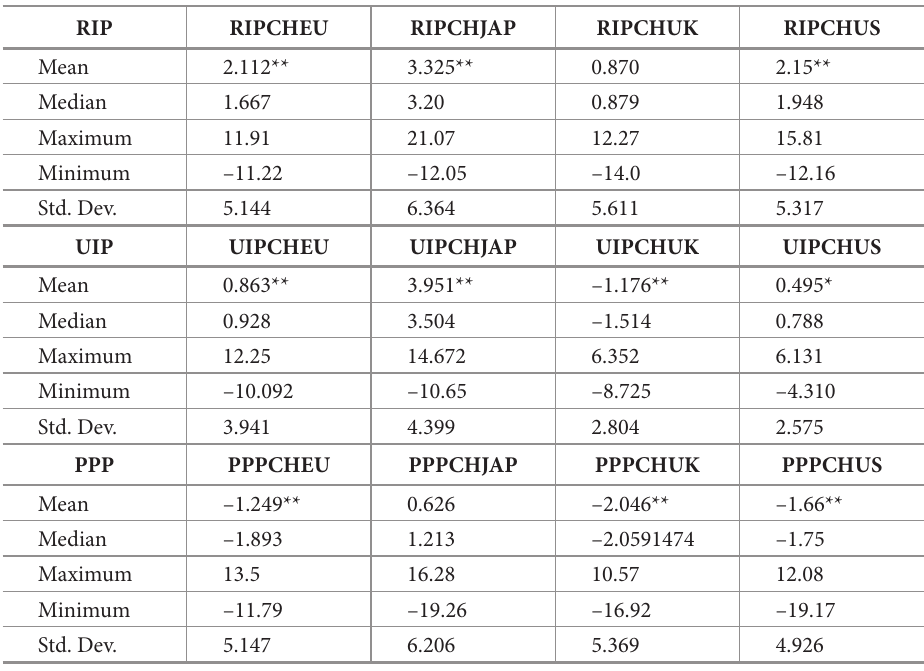
table 1. Descriptive